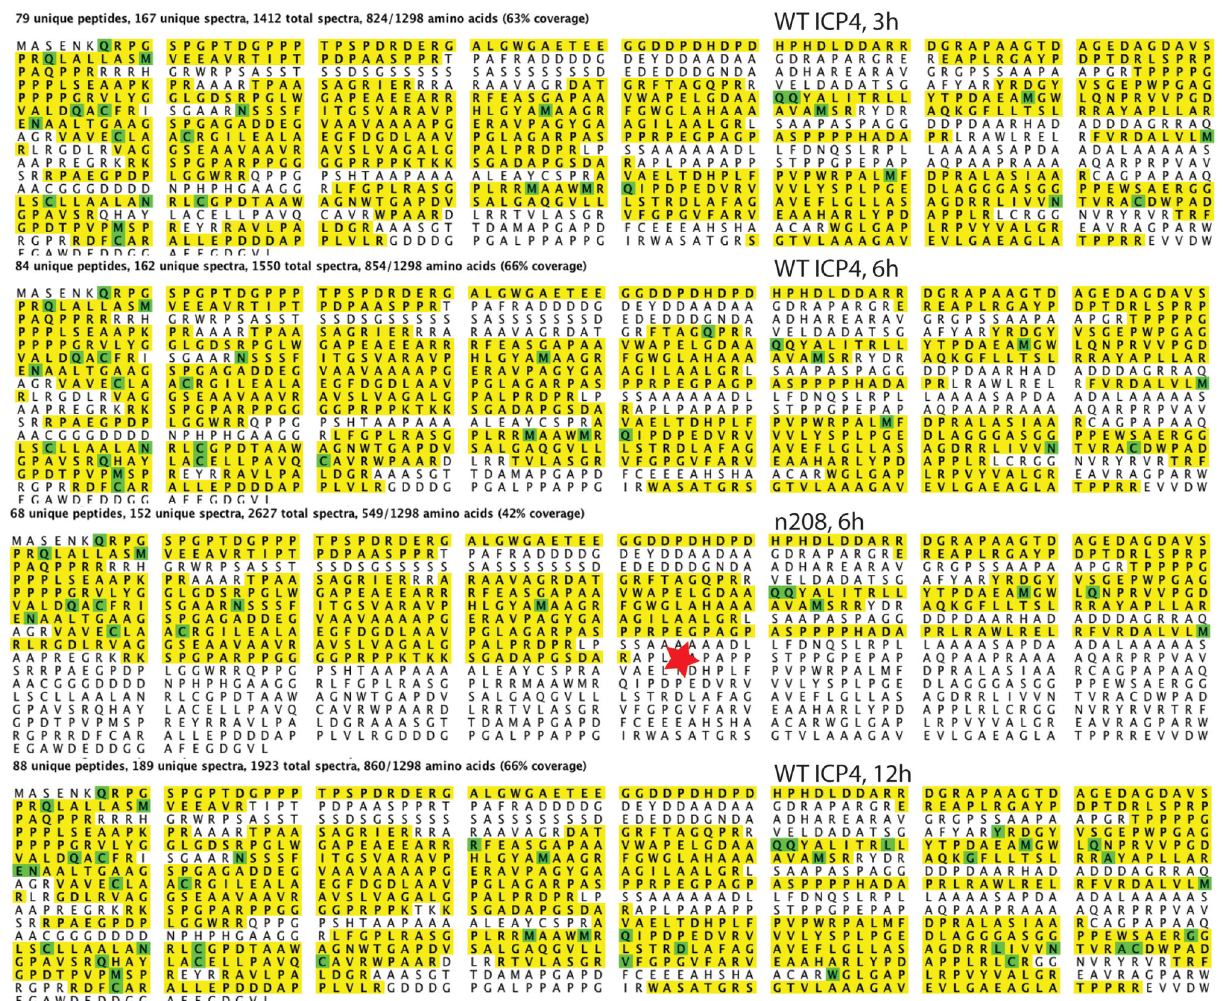
Figure 2. LC-MS/MS peptide coverage and spectral counts of ICP4 affinity purified form infected cells. The peptide coverage of ICP4 for the 3, 6, and 12 h infections and the n208 infection is shown highlighted in yellow relative to the amino acid sequence of ICP4. The green highlighted amino acids are those recognized as modified. The red star is location of the engineer translational stop codon in